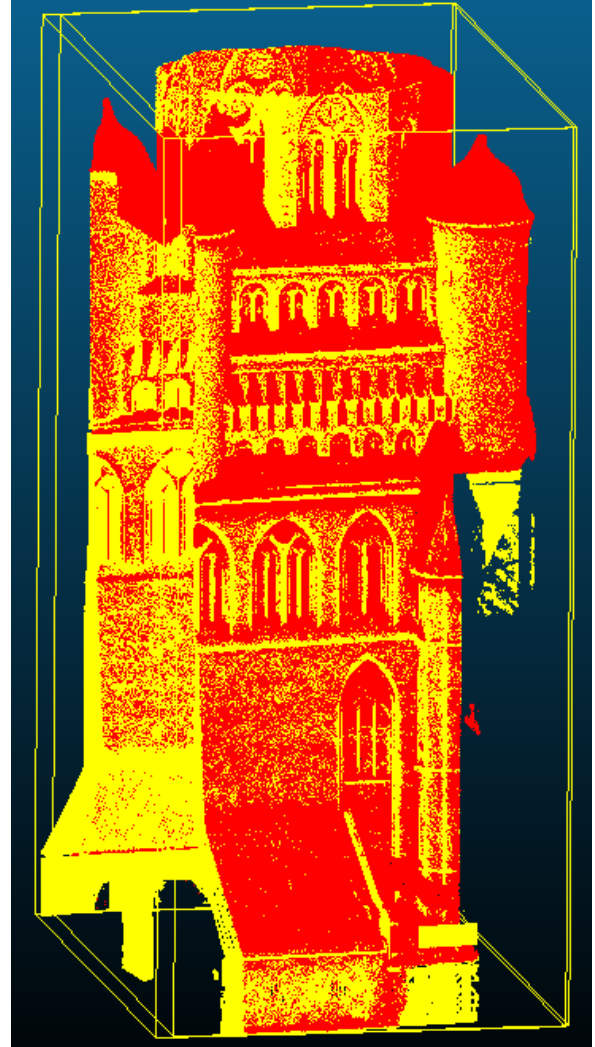
Figure 11. Clips of both point clouds (TLS – yellow, UAS – red) in the lower to mid range of the tower